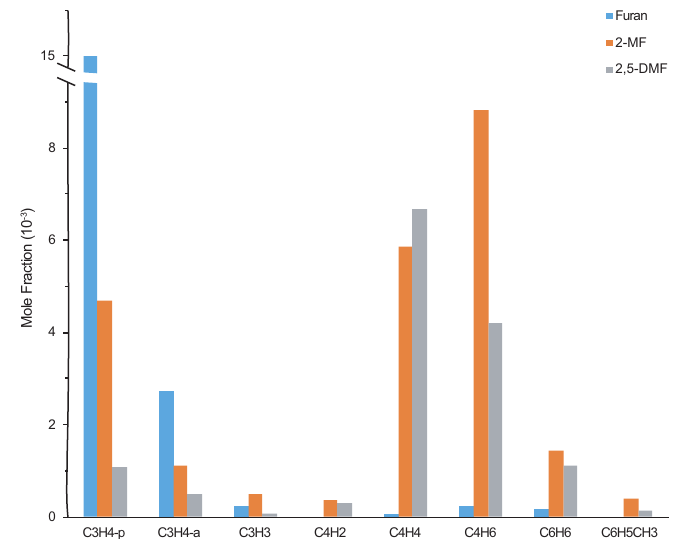
Figure 6. Comparison of measured mole fractions of pyrolysis products 2-MF, 2,5-DMF and furan at 75% fuel conversion (adapted from Cheng et al.